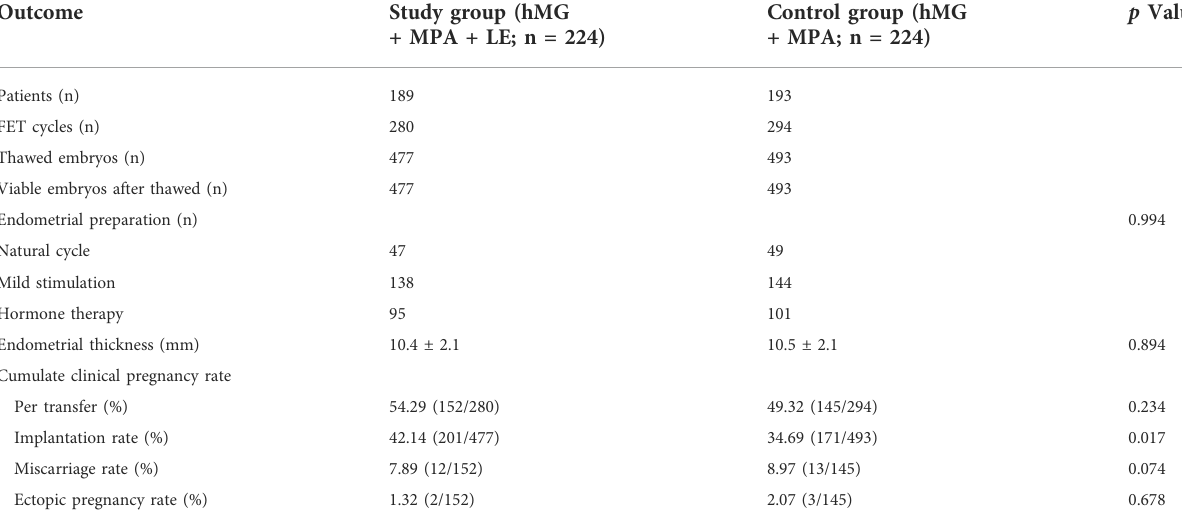
TABLE 3 Pregnancy outcomes of frozen-thawed embryos from the two groups. Outcome Study group (hMG